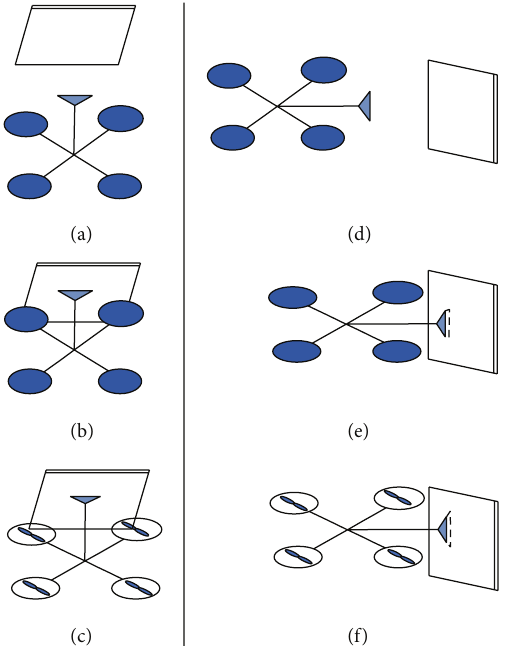
Figure 2: Top perching and side perching: the robot performs several phases when switching from flying to perching. The top perching robot equipped with a quadrotor and suction cup flies to the ceiling and hangs on the ceiling. (a) Top perching approaching step, (b) top contact step, and (c) top perching rest step. The side perching robot with suction cup flies and perches on the wall. (d) Side perching approaching step, (e) side contact step, and (f) side perching rest step.